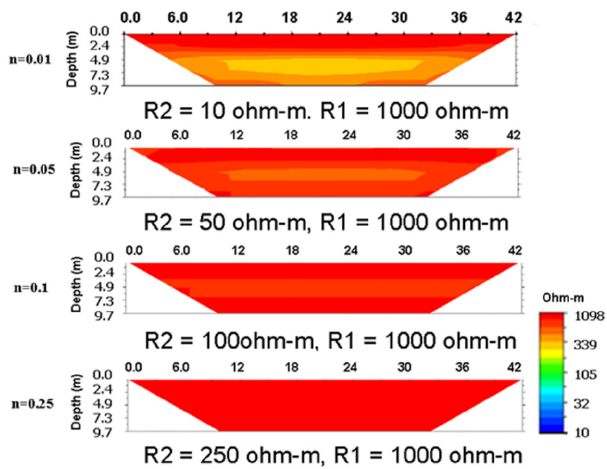
ff ect influence on the pipeline stratum Figure 5. The resistivity ratio and the 3D effect influence on the pipeline stratum model. Figure 5. The resistivity ratio and the 3D e